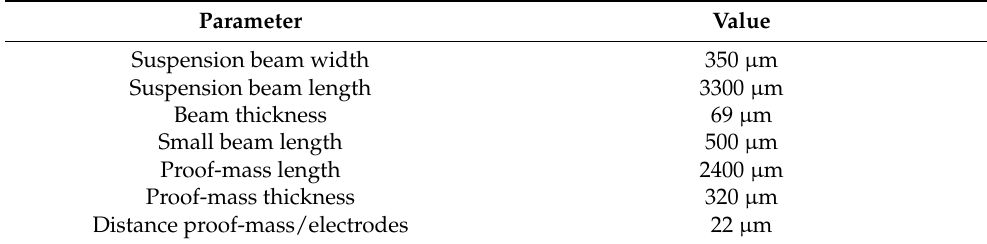
Table 1. Initial geometric parameters of the MEMS accelerometer.